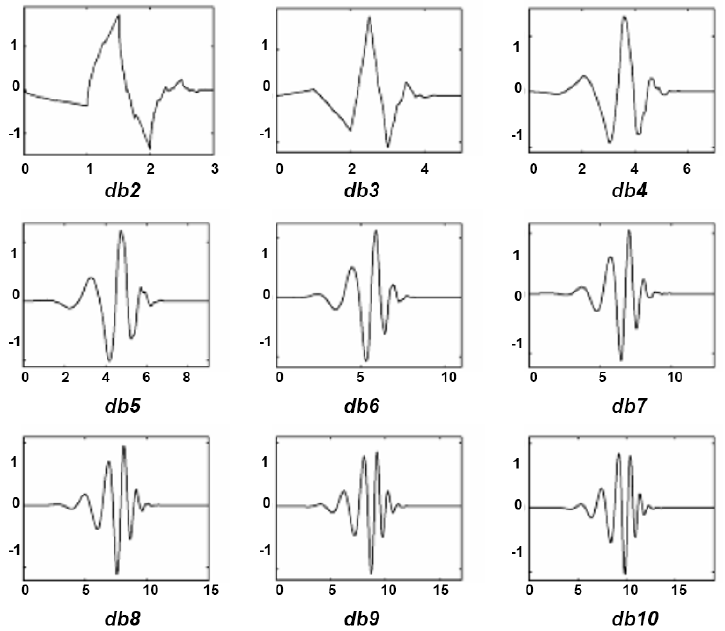
Figure 3. Daubechies wavelet order 2 until 10, which have an asymmetric shape and regularly increase with order.